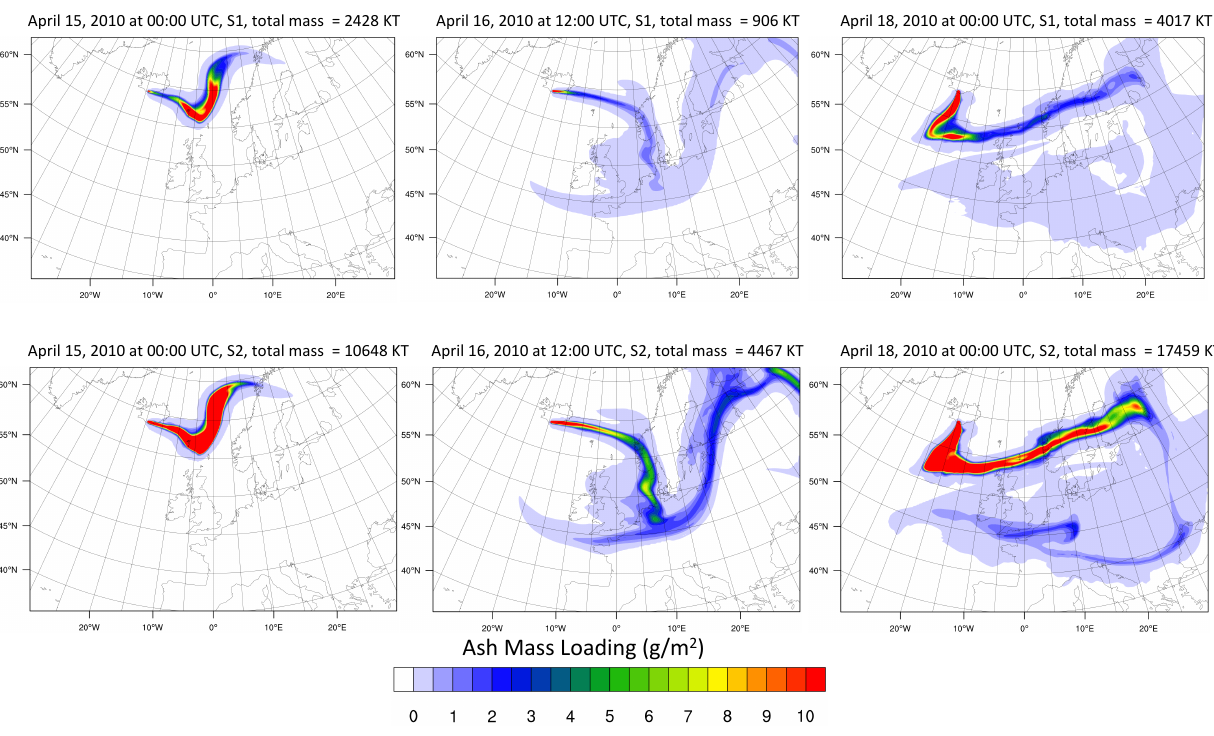
Fig. 5. Daily WRF-Chem dispersion of the Eyjafjallajokull ash mass loading from 15 to 18 April 2010. The top 3 panels represent WRF-Chem model results using the S1 particle size distribution; the bottom panels represent WRF-Chem results with the S2 particle size distribution.